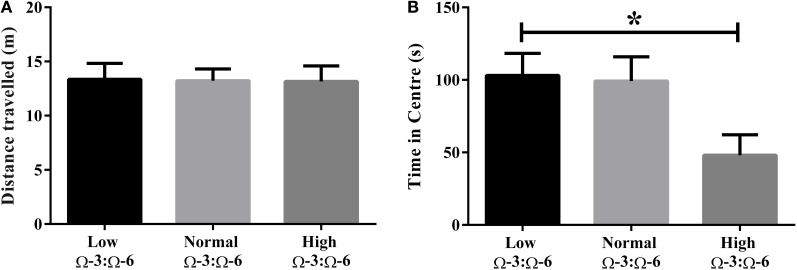
Locomotor activity and anxiety in the open field. (A) Locomotor activity of mice in the open field measured by distance traveled and (B) anxiety-like behavior in mice measured by time spent in the center of the open field. Data analyzed by One-Way ANOVA within strains with Tukey's post-hoc test, *p < 0.05, as indicated on figure. All data presented as mean ± SEM (n = 10/group).